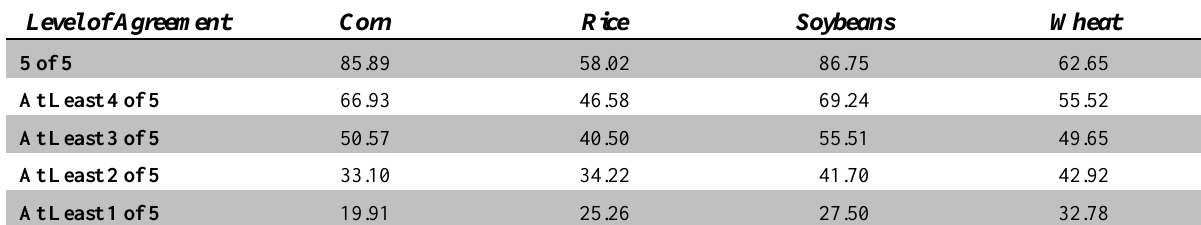
Table 6. MODIS 250 m median crop probability for countries with 25% or more of cropland area in corn, rice, soybeans or wheat, as a function of heritage global cropland map agreement. Level of Agreement Corn Rice